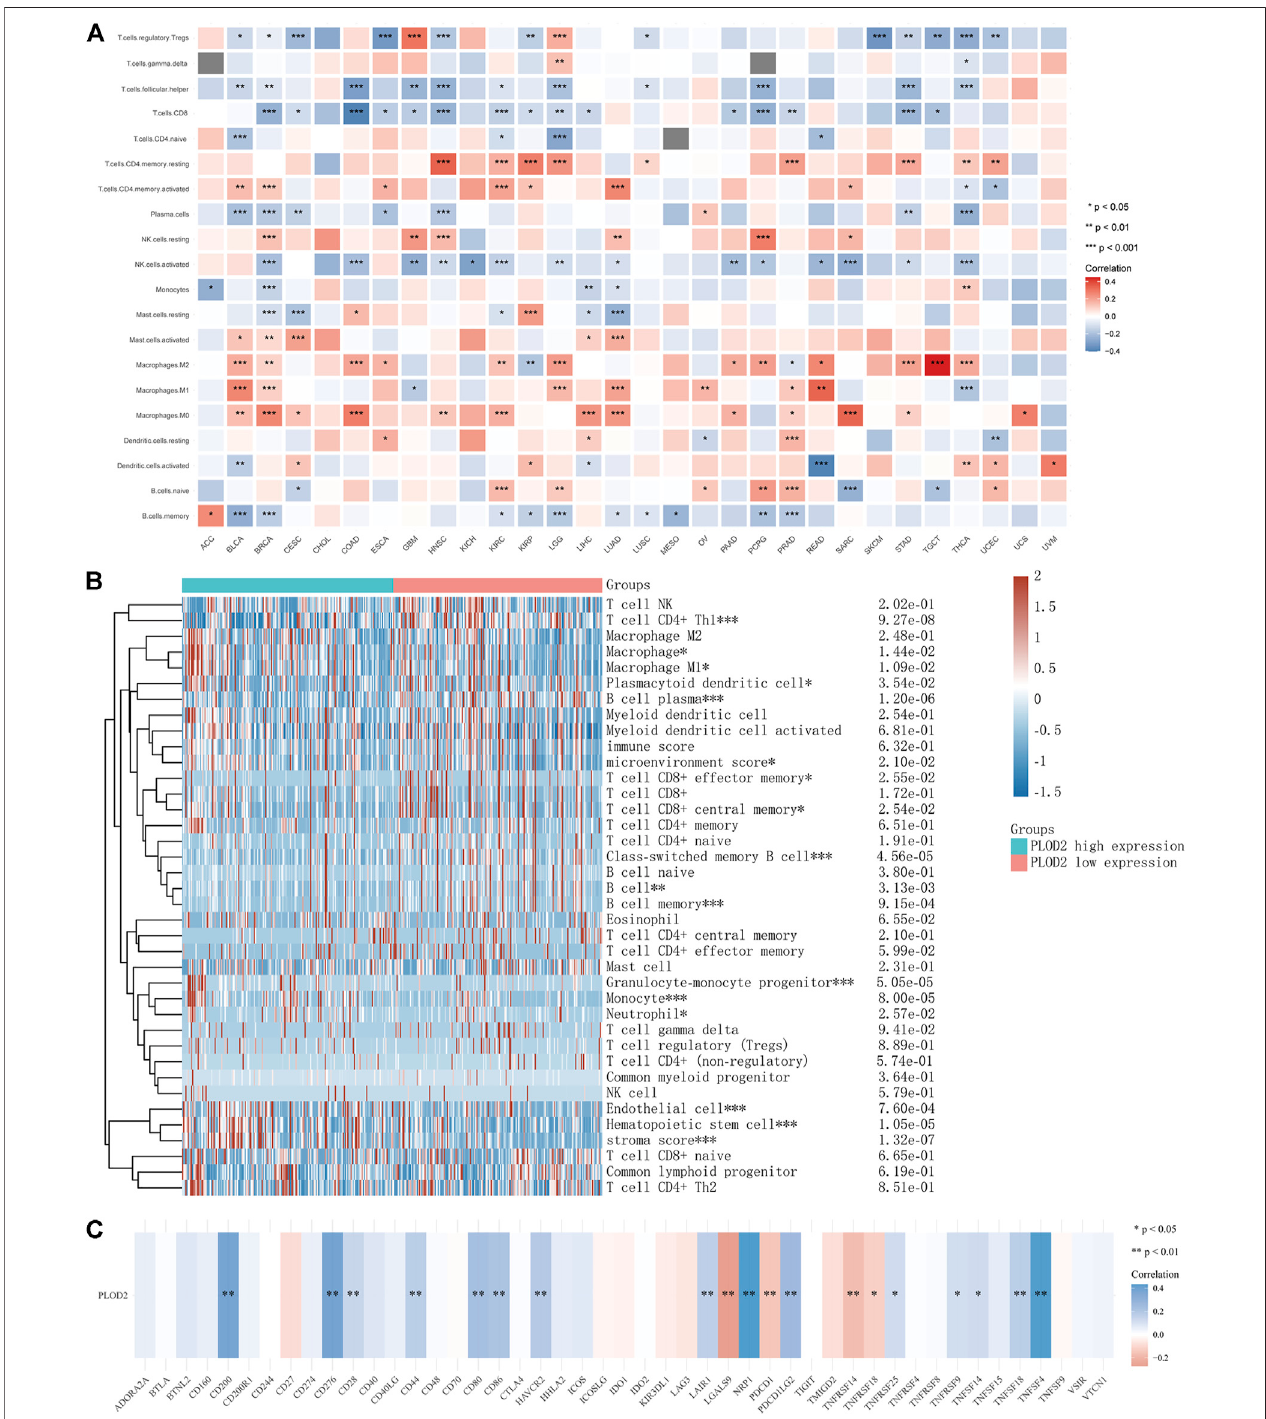
FIGURE 8 | Relationship between PLOD2 expression and immunecellsin pan-cancer. (A) CIBERSORT predictsthat PLOD2 expression is correlated with immunocytes. (B) Heatmap of PLOD2 expression and in fi ltrating immune cells in STAD based on the xCELL algorithm. (C) relationship between PLOD2 and immune checkpoint in STAD.